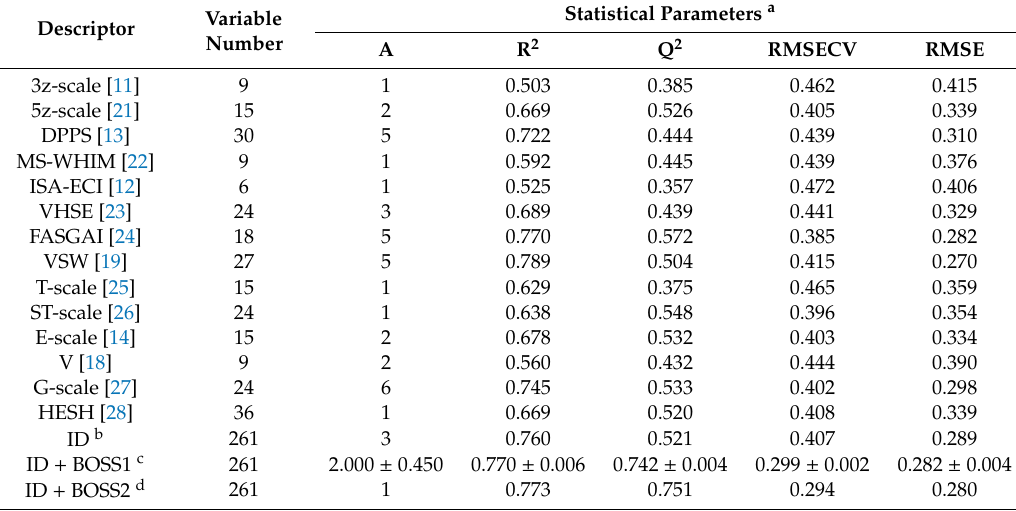
Table 3. Statistical parameters of QSAR models for tripeptides using a single set of amino acid descriptor and comparison with models built by integrated descriptor